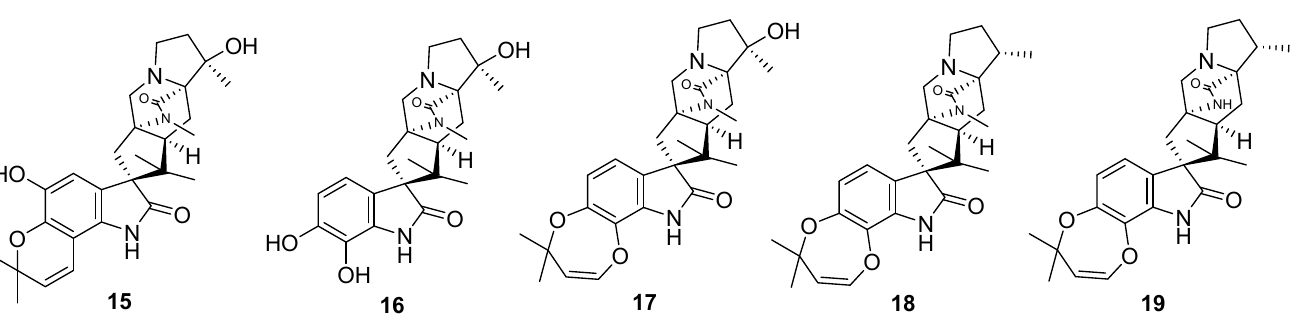
Figure 7. Spirooxindoles 15–19 isolated from the marine fungus Penicillium janthinellum HK1–6.